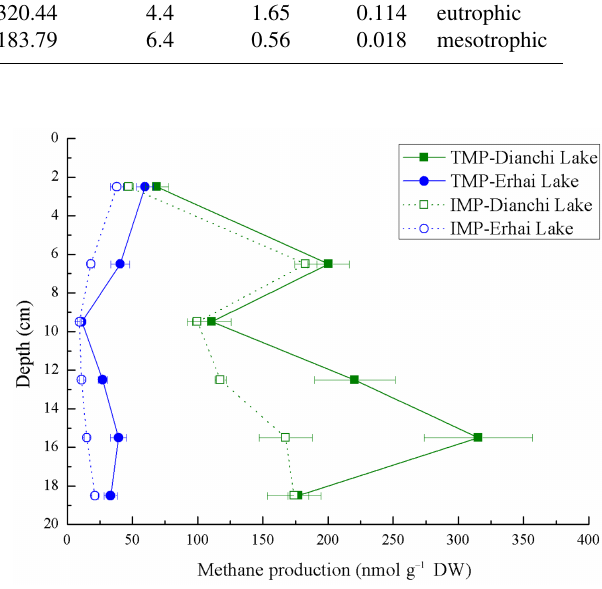
Figure 1. Uninhibited (TMP) and 2% CH 3 F inhibited (IMP) methane production potential at different depths. Error bars repre- sent standard deviation of mean ( n =